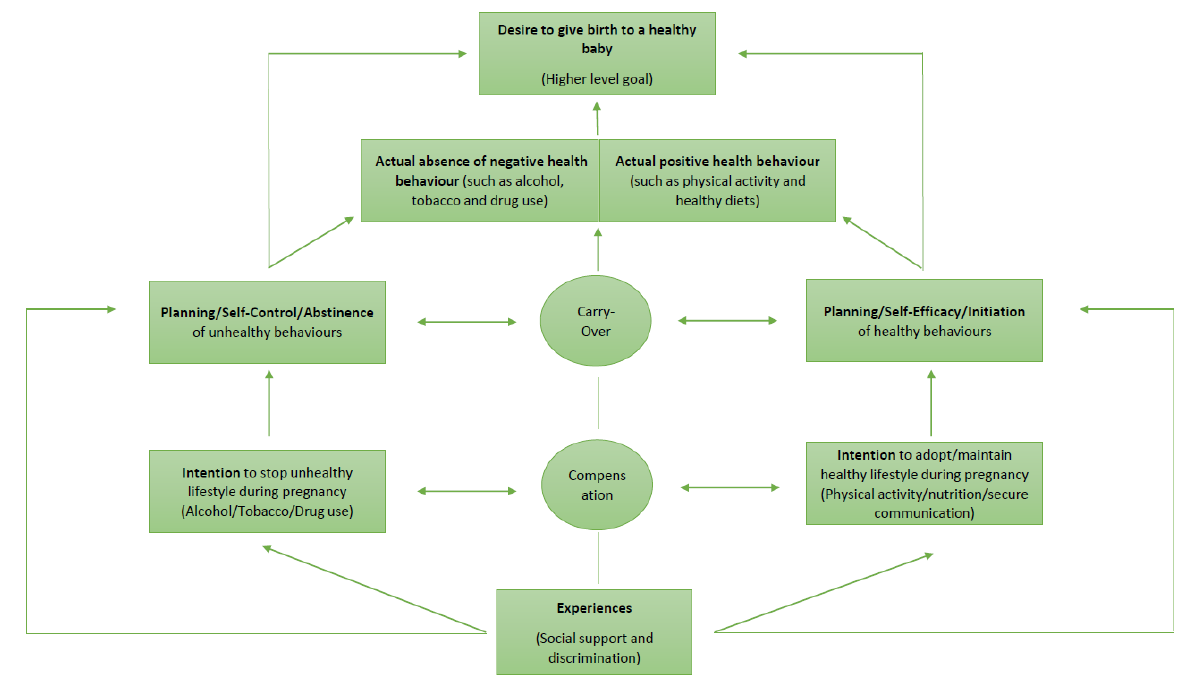
Figure 1. Schematic illustration with assumption of the Compensatory Carry-Over Action Model (CCAM, adapted from Lippke, 2021), applied to health behaviors during pregnancy, including experiences (e.g., social support and discrimination).